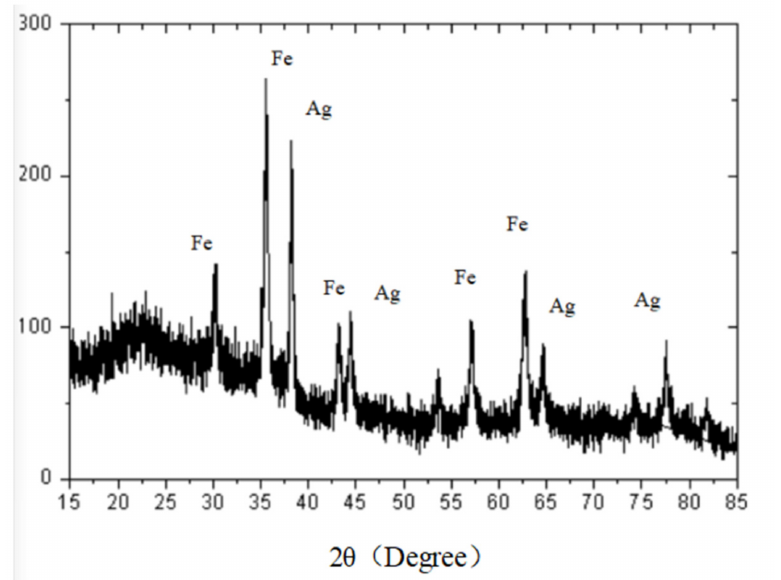
Figure 4. XRD of Fe 3 O 4